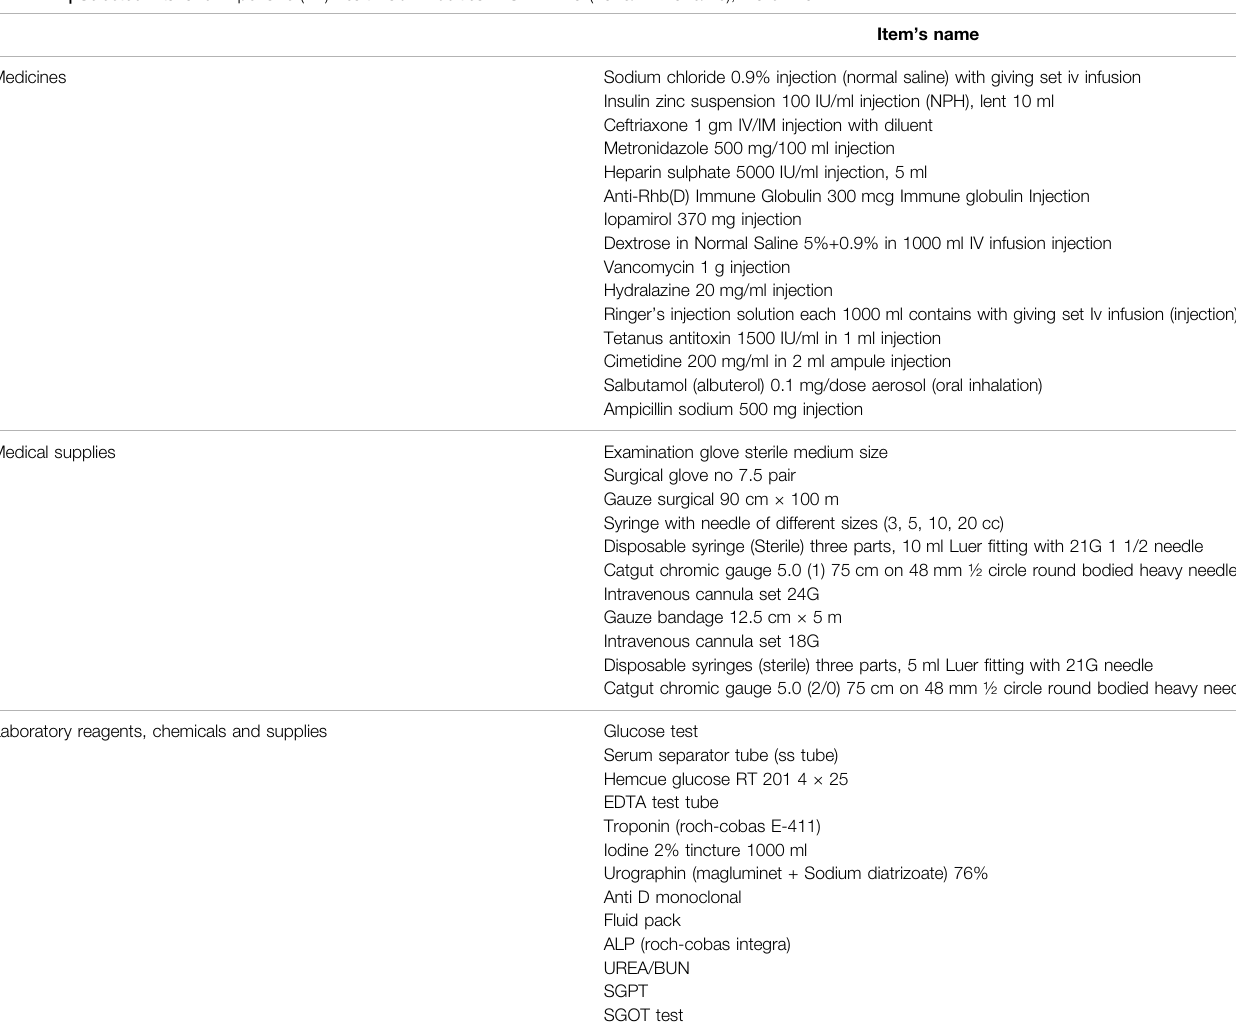
TABLE 4 | Selected Vital and Expensive (AV) health Commodities in SPHMMC (2013/14-2015/16), March